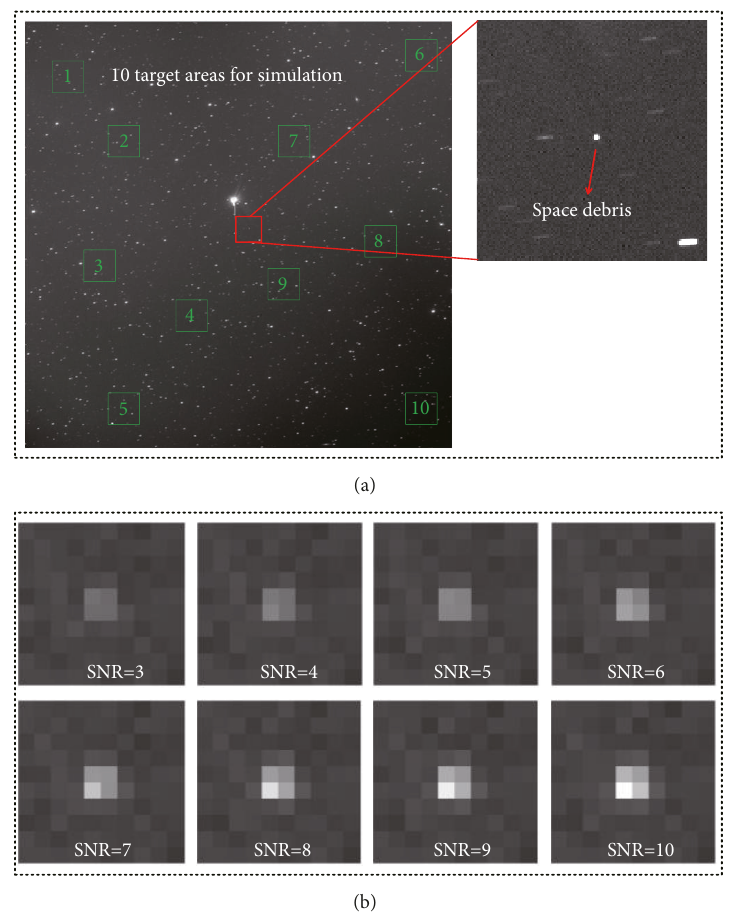
Figure 5: (a) A frame captured by the ground-based telescope. (b) Simulated pieces of space debris with different SNRs.